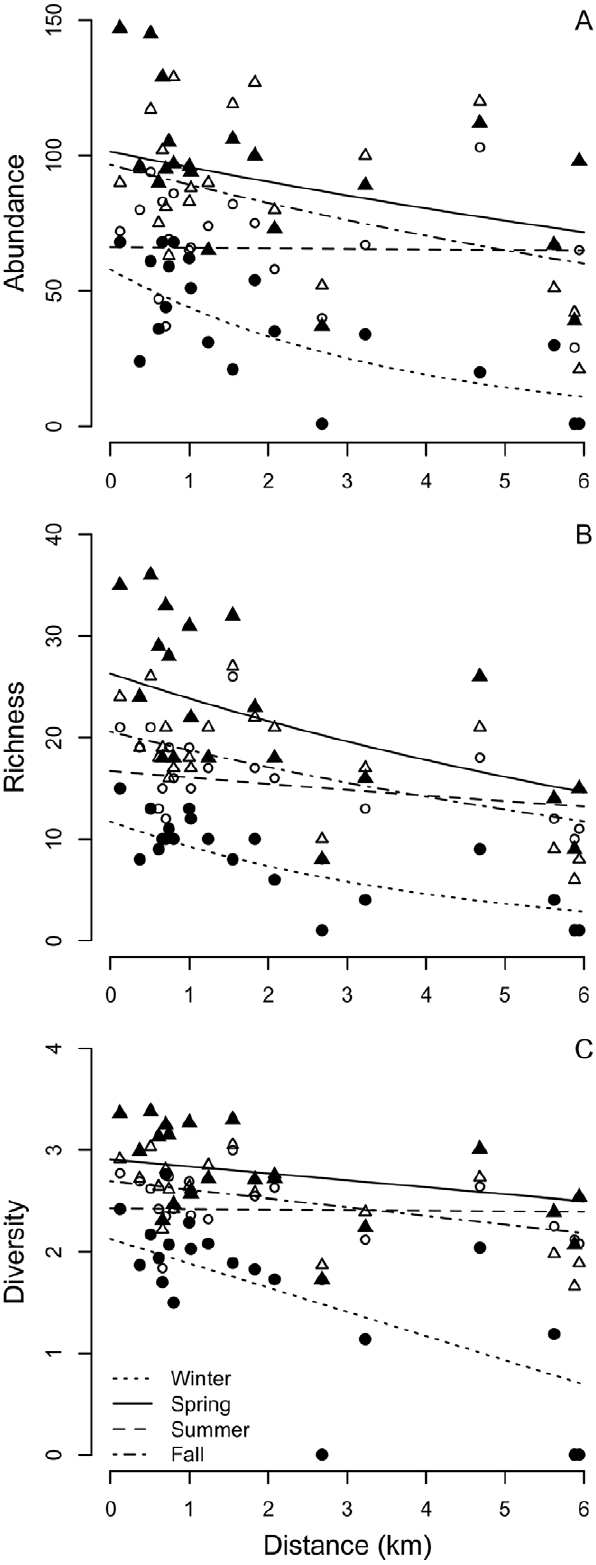
Figure 2. Effect of distance to vegetated lots on avian community structure. Relationships of avian (A) abundance, (B) richness, and (C) diversity are characterized for winter (closed circles),